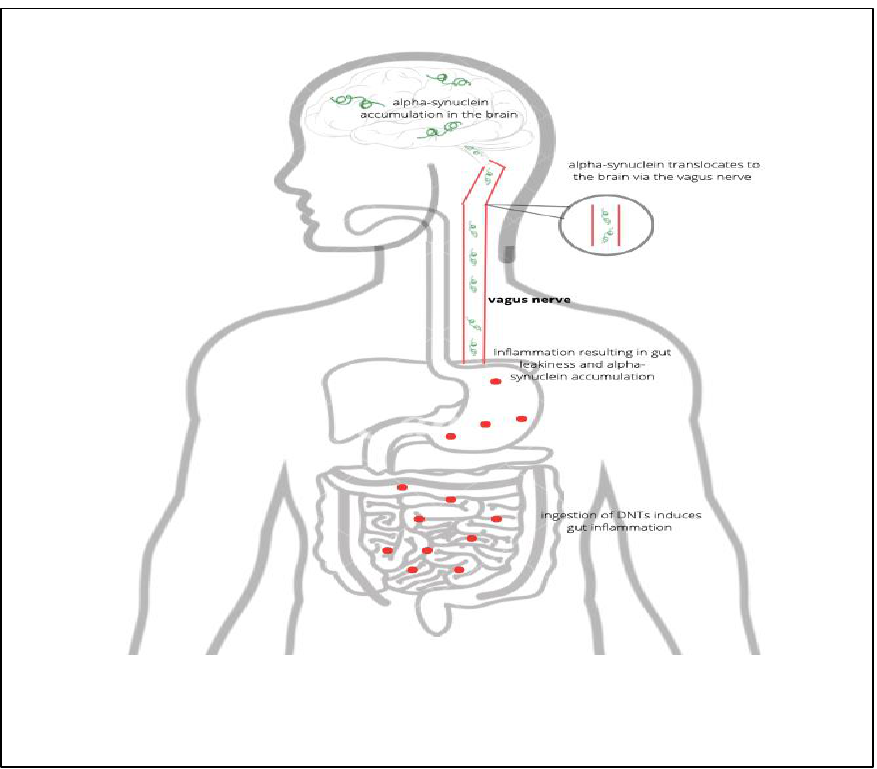
Figure 3. Ingestion of air pollutants leading to alpha-synuclein accumulation in the brain. Graphical illustration idea was adapted from [58], with permission from Wiley Online Library, 2022.